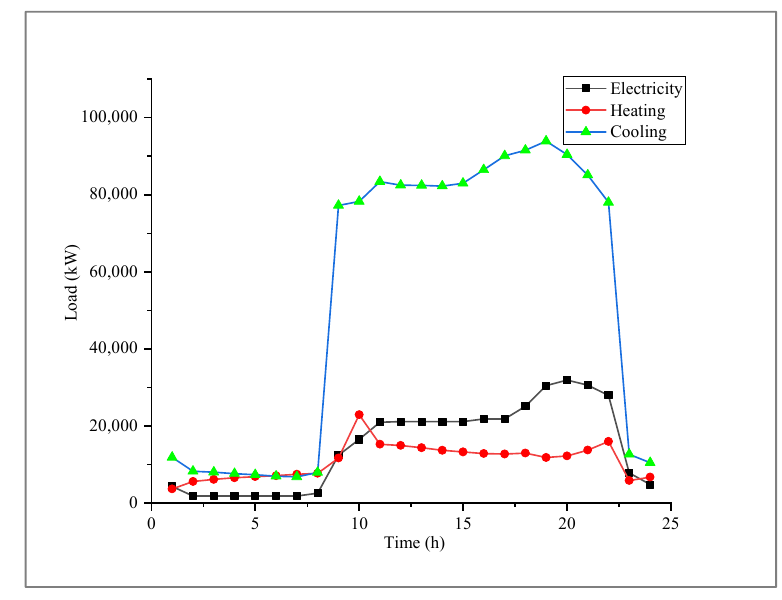
Figure 5. Load of cooling, heating, and electricity when TR = 0.